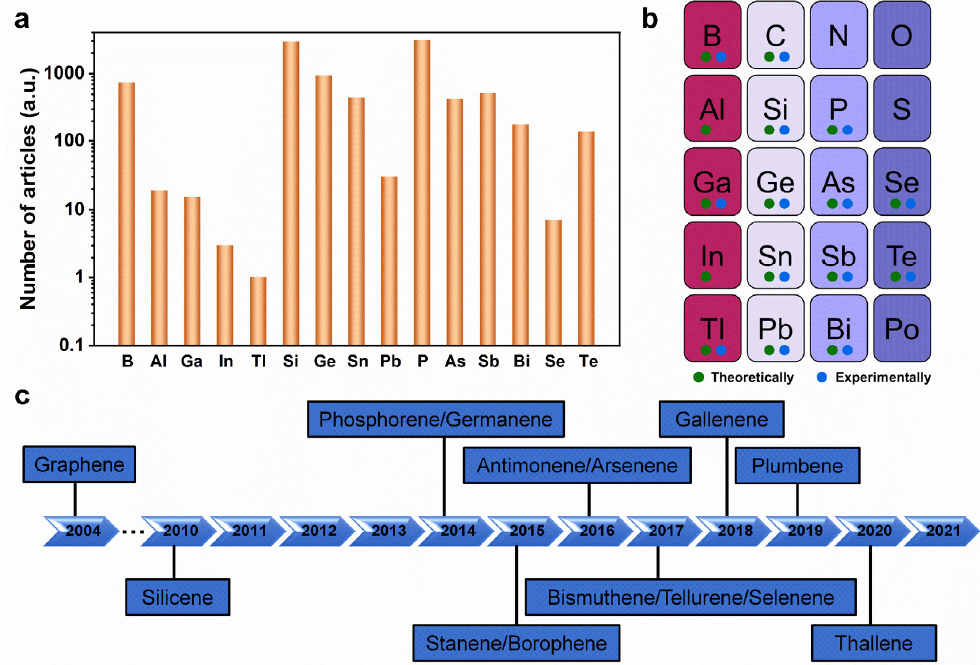
Figure 1. Development of 2D Xenes. ( a ) Statistics diagram of the number of research articles on non‑graphene 2D Xenes from 2010 to 2021. ( b ) Overview of 2D analogs of main‑group elements, explored using either experimental or theoretical routes. The elements with no signs have not been explored to date. ( c ) The timeline of the experimental creation of 2D Xenes.